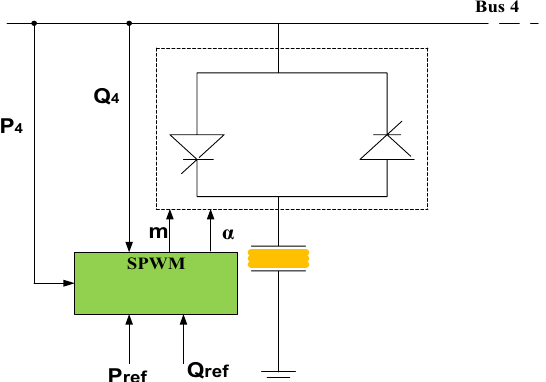
Fig. 12 Structure of TSC